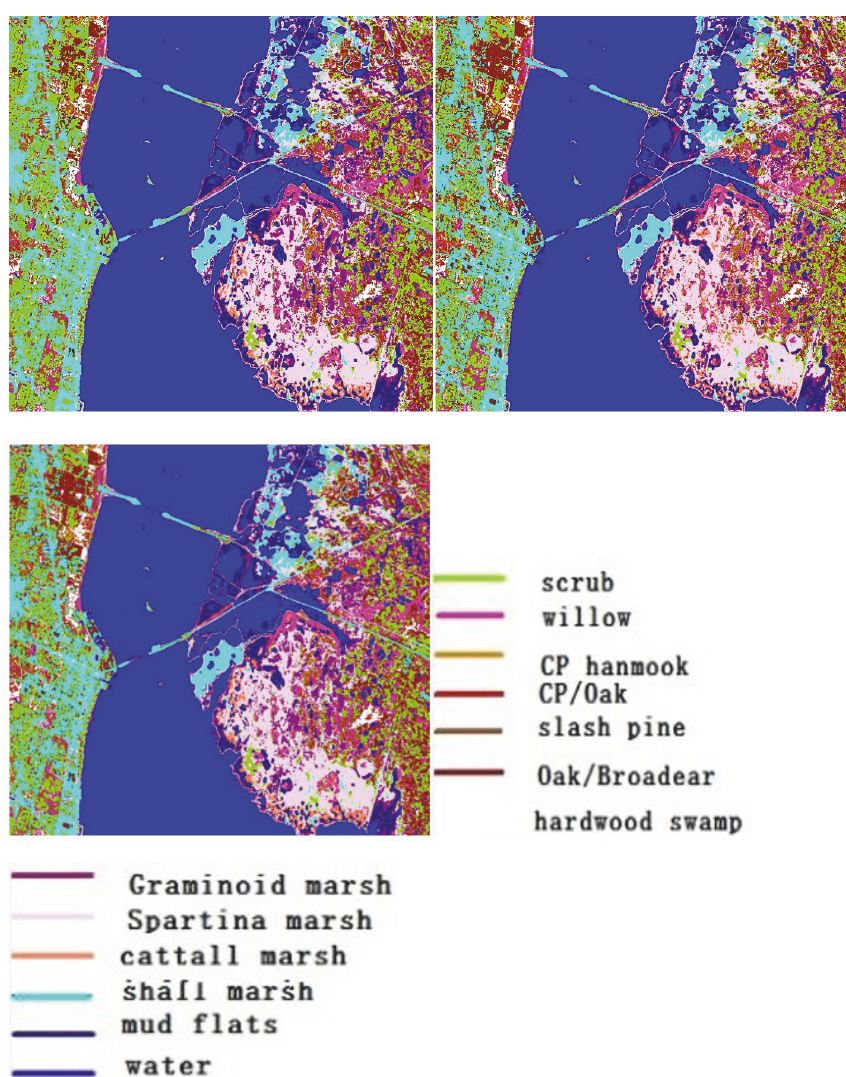
Figure 14: The classification results of minimum distance algorithm for AVIRIS